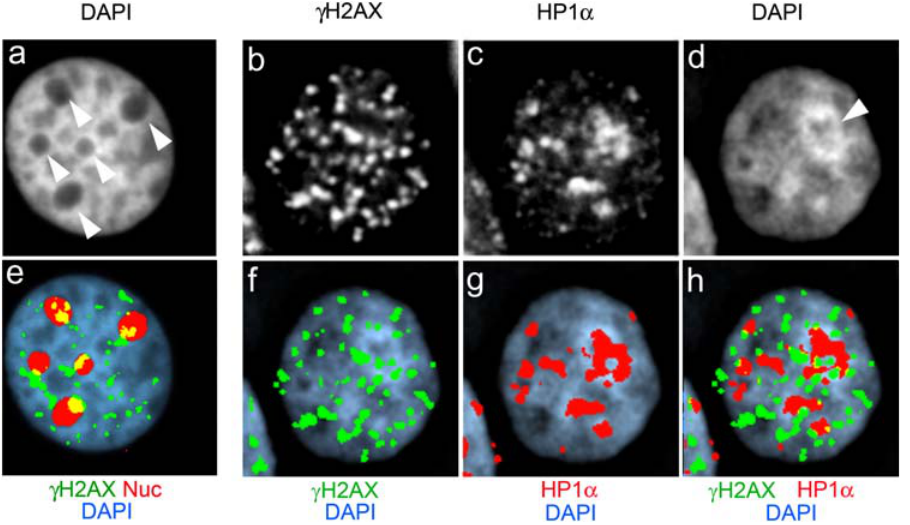
Figure 3. Spatial relationship between c H2AX foci, HP1 a -staining heterochromatic regions and nucleoli. Panel b–d and f–h were obtained from a single nucleus fixed 30 minutes after X-irradiation (2Gy) and processed for c H2AX and HP1 a immunofluorescence. Panels, a & e were obtained from a separate irradiated nucleus processed for nucleolin and c H2AX immunofluorescence. Panel a, DAPI; b, c H2AX; c, HP1 a ; d, DAPI; e, merged DAPI (blue) and nucleolin (red), c H2AX (green) images; f, c H2AX (green)/DAPI (blue); g, HP1 a (red)/DAPI (blue); h, c H2AX/HP1 a /DAPI. In panels e–h, the red and green chanels were reduced to binary images, retaining as much detail as possible, before overlaying on the DAPI image. DAPI staining was carried out under optimum conditions to reveal nuclear structure. doi:10.1371/journal.pone.0001057.g003 PLoS ONE |